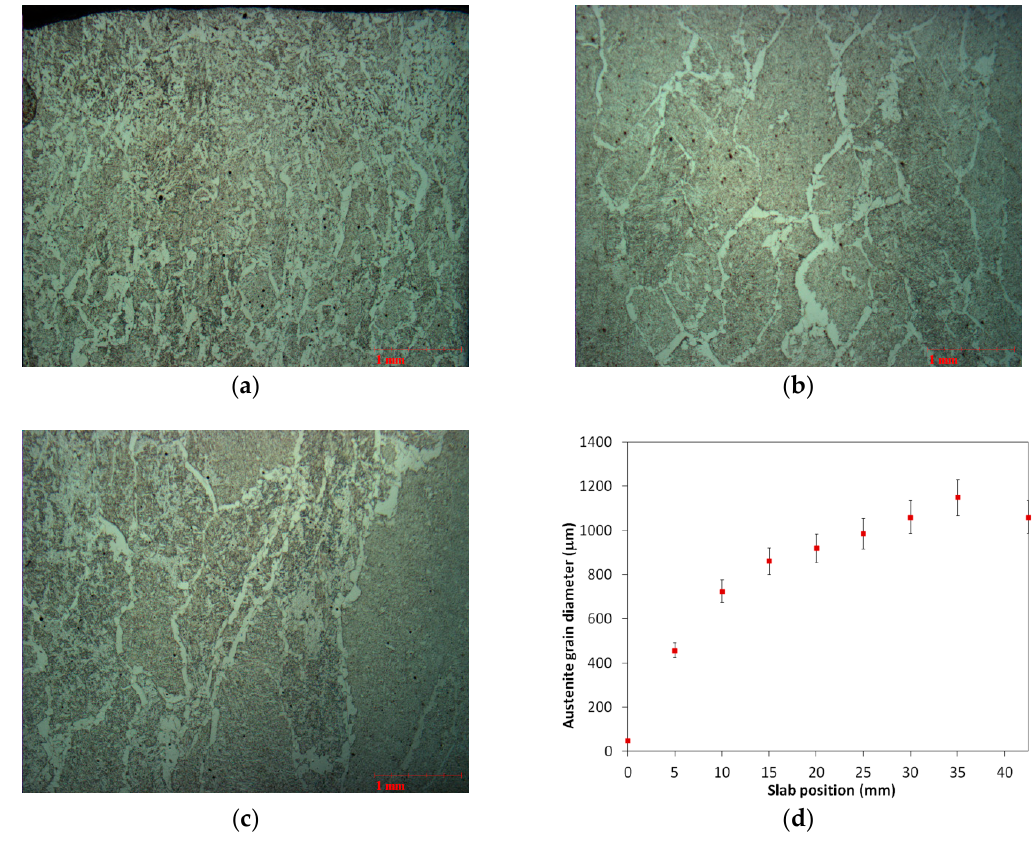
Figure 2. 85-mm slab austenite grain size evolution of American Petroleum Institute (API) X70 from the industrial thin slab casting process: ( a ) close to slab surface; ( b ) 20 mm from the slab surface; ( c ) close to the slab center; and ( d ) summary of the measured austenite grain size with distance from slab surface to center.